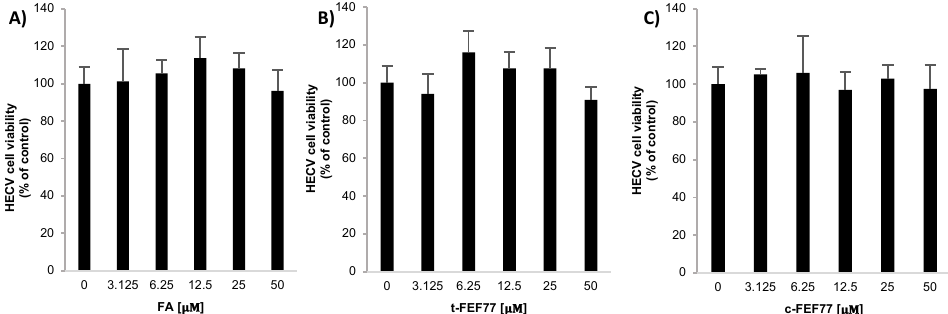
Figure 3. Viability of human endothelial cord vein (HECV) cells treated with: ( A ) FA, ( B ) t-FEF77, or ( C ) c-FEF77 at 3.125, 6.25, 12.5, 25, and 50 μ M for 24 h. Data are expressed as percent vs. control (0). Values are mean ± S.D from at least three independent experiments.